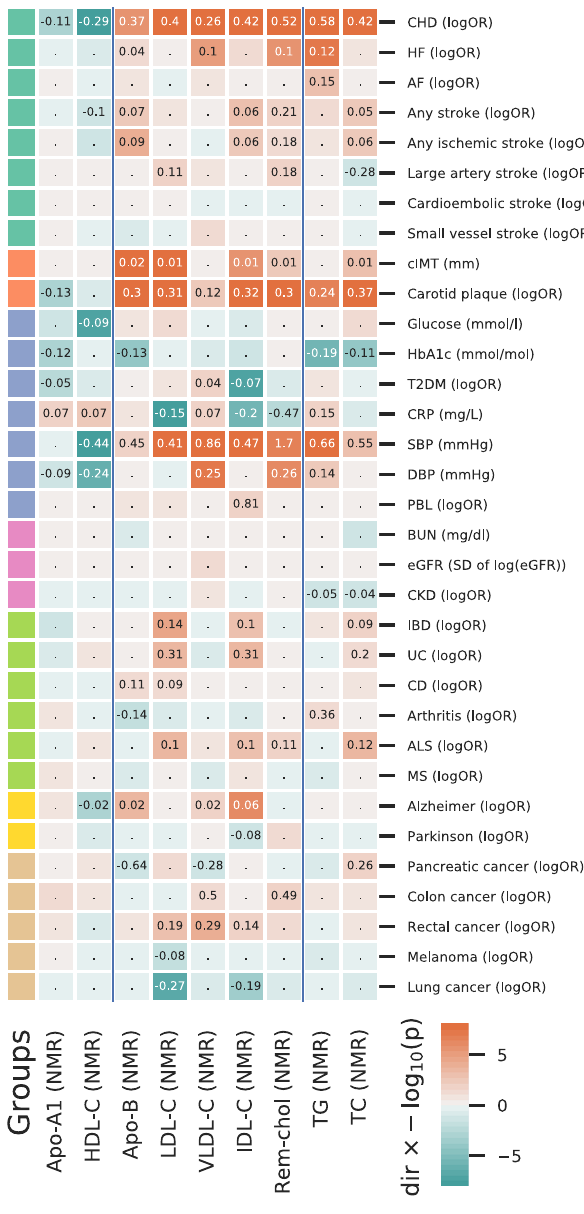
Fig. 2 Mendelian randomization estimates of the total effects of a one SD increase in cholesterol-containing lipoprotein and apolipoprotein concentrations. Cells are coloured by the effect direction multiplied by -log 10 ( p value), with the point estimate (the mean difference or log odds ratio) provided for results with p values smaller than 0.05. The p values were truncated at 1 × 10 − 8 for display purposes. Analyses are based on a 33,029 subject meta-analysis of Kettunen 15 and UCLEB 20 . LDL-C low- density lipoprotein cholesterol, HDL-C high-density lipoprotein cholesterol, TG triglycerides, VLDL-C very-low-density lipoprotein cholesterol, IDL-C intermediate-density lipoprotein cholesterol, Rem-chol remnant- cholesterol, TC total cholesterol, Apo-B apolipoprotein-B, Apo-A1 apoliprotein-A1. CHD coronary heart disease, HF heart failure, AF atrial fi brillation, T2DM type 2 diabetes mellitus, CKD chronic kidney disease, IBD in fl ammatory bowel disease, CD Crohn ’ s disease, UC ulcerative colitis, ALS amyotrophic lateral sclerosis, MS multiple sclerosis, PBL primary biliary liver cirrhosis, DBP and SBP diastolic and systolic blood pressure, CRP c-reactive protein, HbA1c glycated haemoglobin, BUN blood urea nitrogen, eGFR estimated glomerular fi ltration rate, cIMT carotid artery intima media